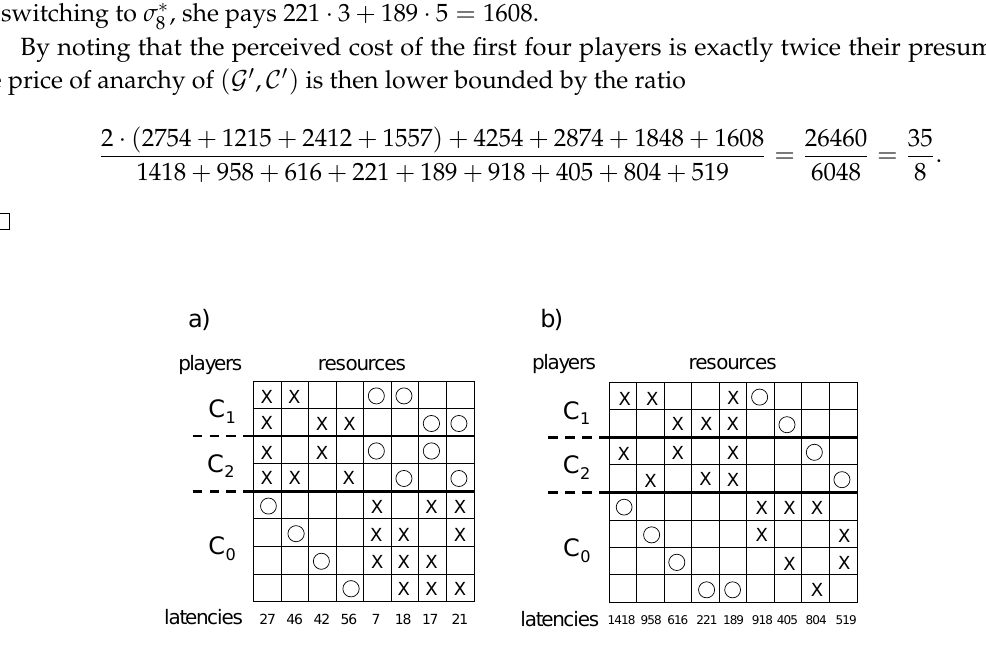
Figure A1. The games depicted in figures ( a , b ) represent the lower bound instances w.r.t. the social cost functions Pres and Perc , respectively. Each column in the matrix represents a resource of cost function (cid:96) ( x ) = α x whose coefficient α is reported at the bottom of the column. Each row i in the matrix models the strategy set of player i as follows: circles represent resources belonging to σ i , while crosses represent resources belonging to σ ∗ i